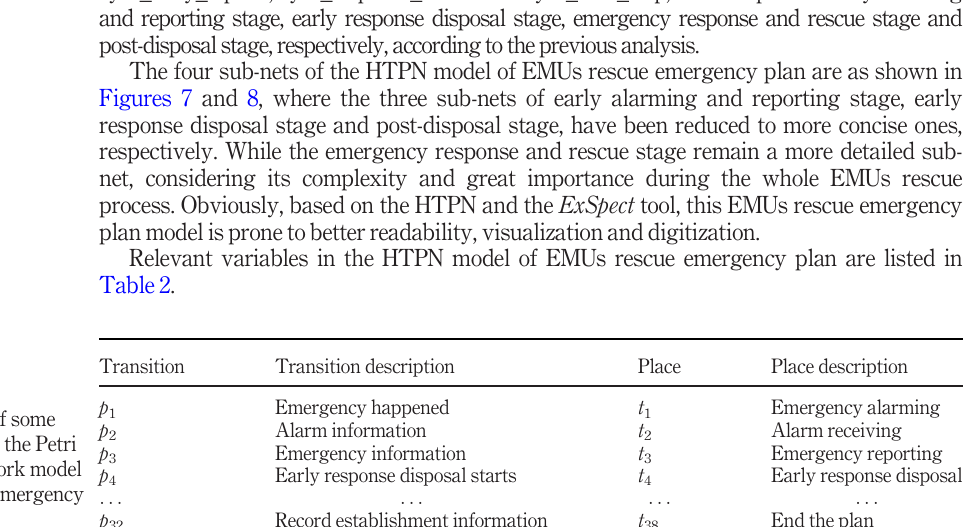
Table 1. De fi nition of some variables in the Petri net framework model of railway